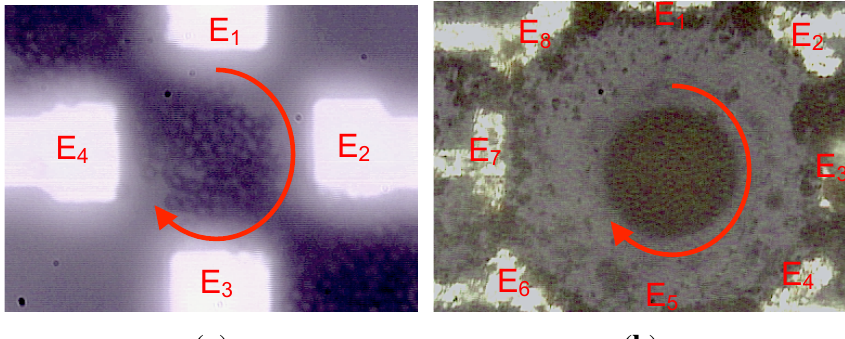
Figure 16. Experimental results of 0.97 µ m diameter polystyrene microspheres (dyed